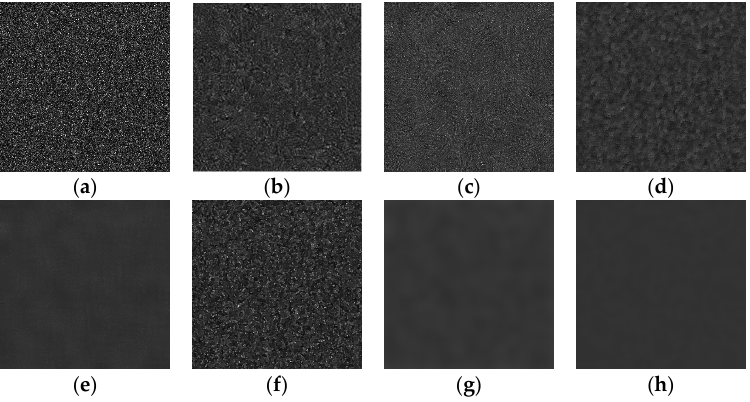
Figure 11. Comparison of different algorithms when the noise variance is 0.5: ( a ) unprocessed, ( b ) BM3D, ( c ) PPB, ( d ) Refined Lee, ( e ) PNLM, ( f ) Adaptive TV, ( g ) FFDNET, and ( h ) proposed.